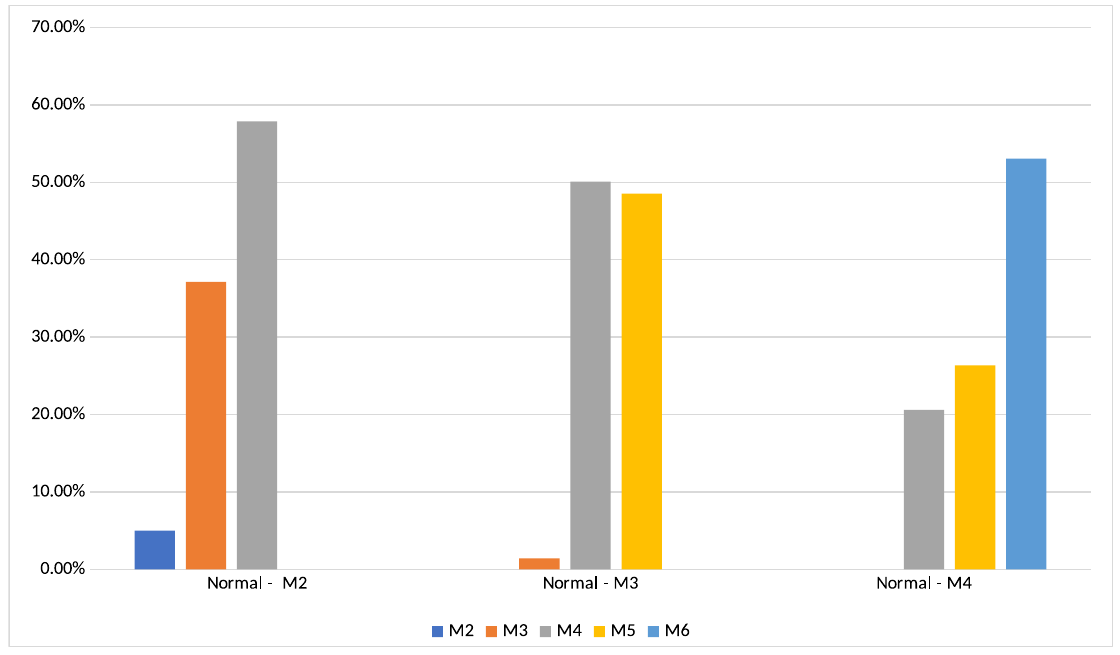
Figure 7. Dynamic control lighting class participation for main lighting